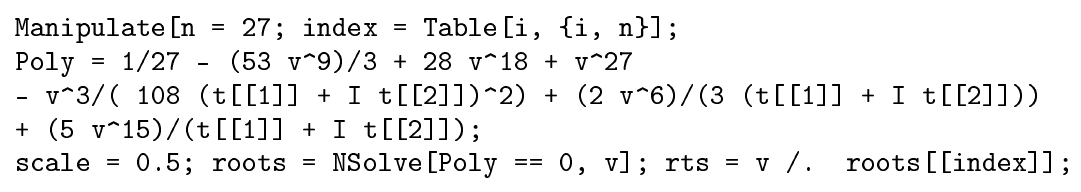
Figure 26: Example of the Mathematica out-put for ( n ( c ) = ( 1,1,0 ) and k = 2. The t -plane and v -plane are plotted in the same , c , c 1 2 3 plane. The black dot sets the value of t and can be dragged. The green dot marks t = 0 while the purple dots mark a fixed reference frame in the t-plane. The roots ( t ) are displayed by red dots. Drag the black dot around the green dot to watch v i them permute. We clearly see three monodromy orbits of cardinality 3,12,5 per- muted